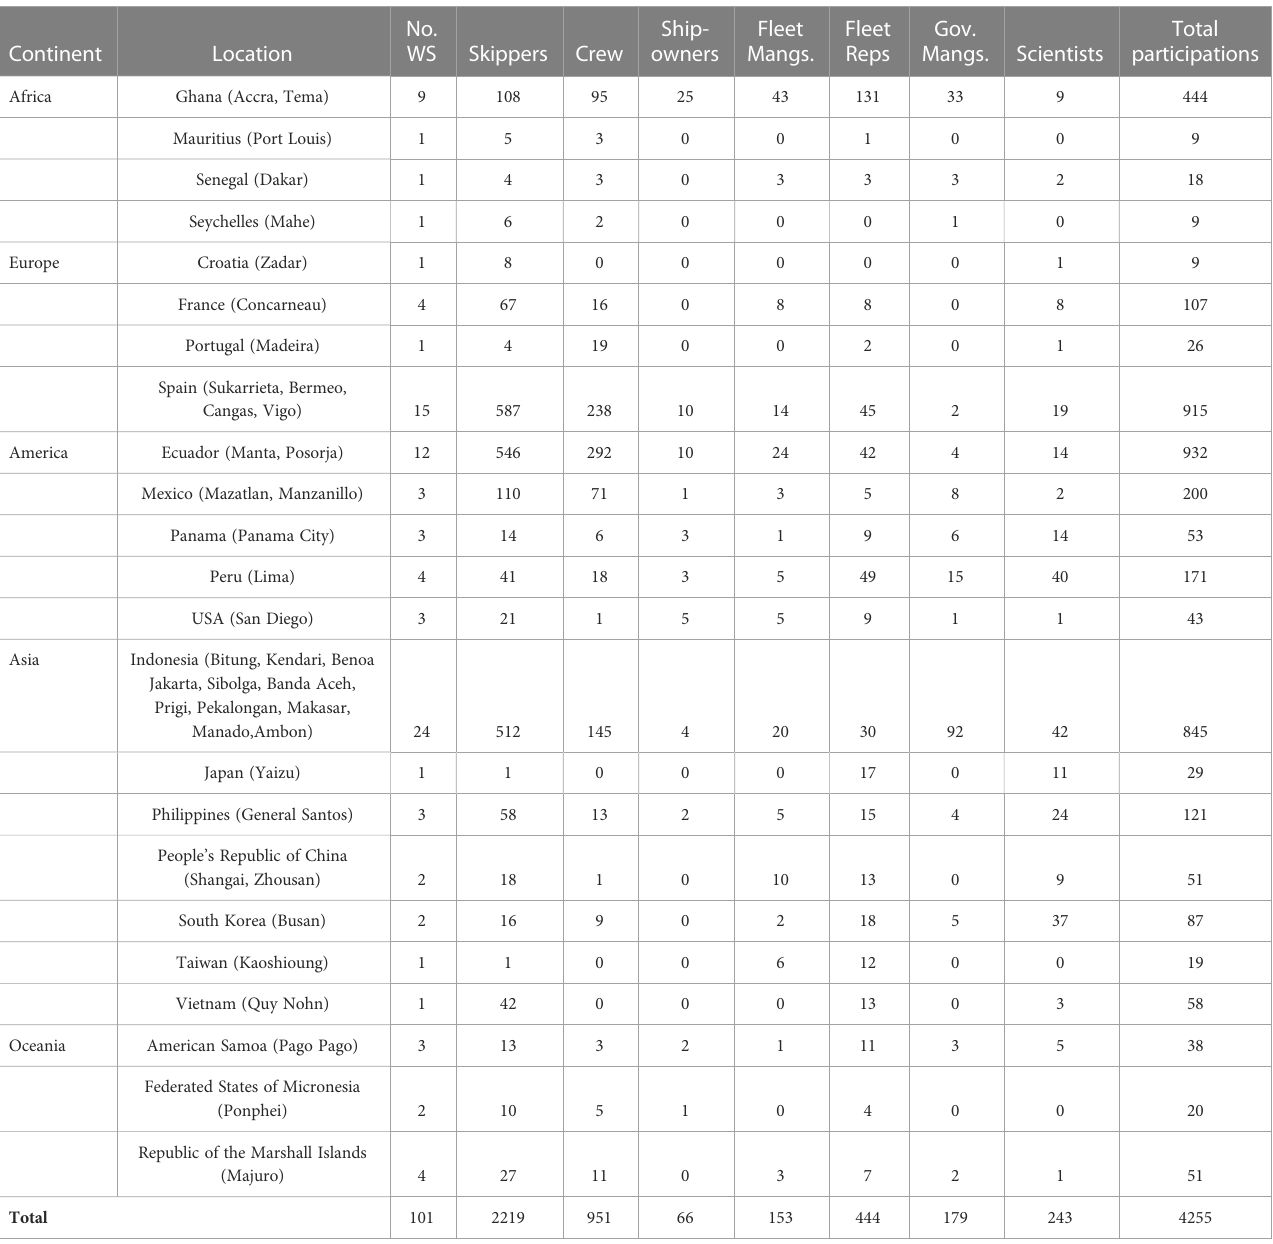
TABLE 1 ISSF Skippers Workshops 2010- 2019 by location and participant number by work occupational group.